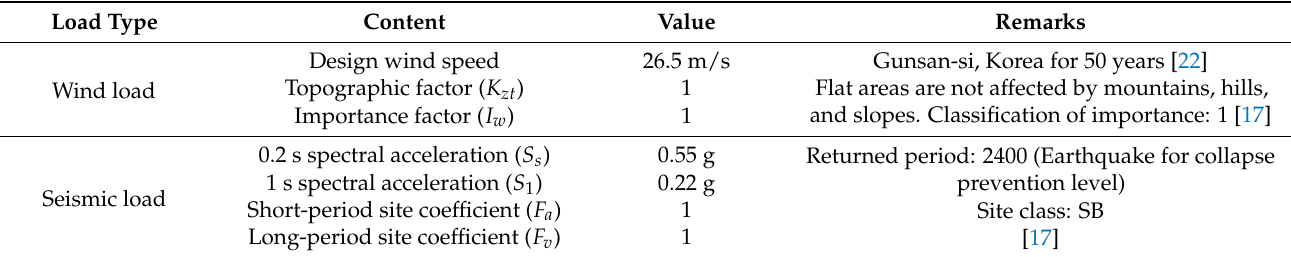
Table 1. Wind and seismic design load conditions.